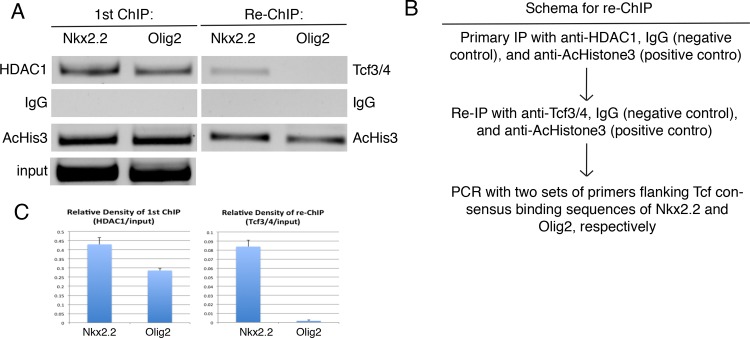
Tcf and HDAC1 proteins occupy Nkx2.2 but not Olig2 regulatory sequences.ChIP-reChIP experiments showing interaction of Tcf4 and HDAC1 with Nkx2.2 but not Olig2 regulatory regions. (A) Left column: Primary IP assays with HDAC1, IgG (negative control), or AcHistone3 (AcHis3) (positive control) antibodies from chromatin prepared from E10.5 mouse embryos. Right column: re-ChIP assays with Tcf3/4, IgG (negative control), or AcHistone3 (positive control) antibodies from primary IP elution. (B) Sequential chromatin immunoprecipitation assay schema. (C) Densitometry analysis of primary IP (left), and re-IP (right) results. The data are expressed as mean± SEM from three independent experiments.